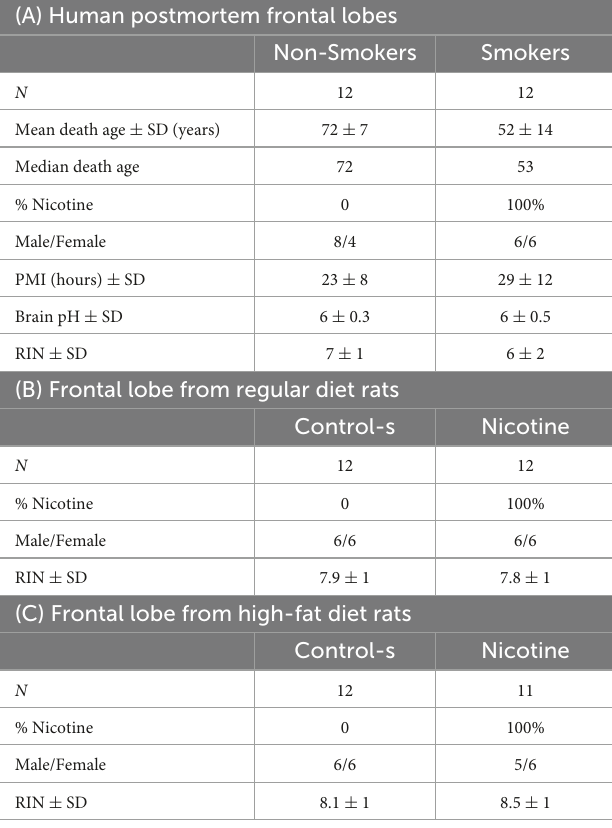
(A) Human postmortem frontal